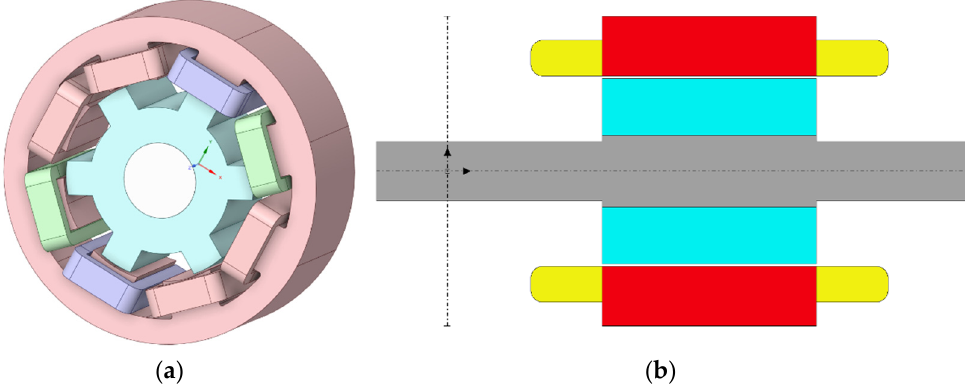
Figure 1. Exemplary construction model geometry for 8/6 SRM motor: ( a ) 3D ANSYS representation; ( b ) cross-section of the modelled motor [13].